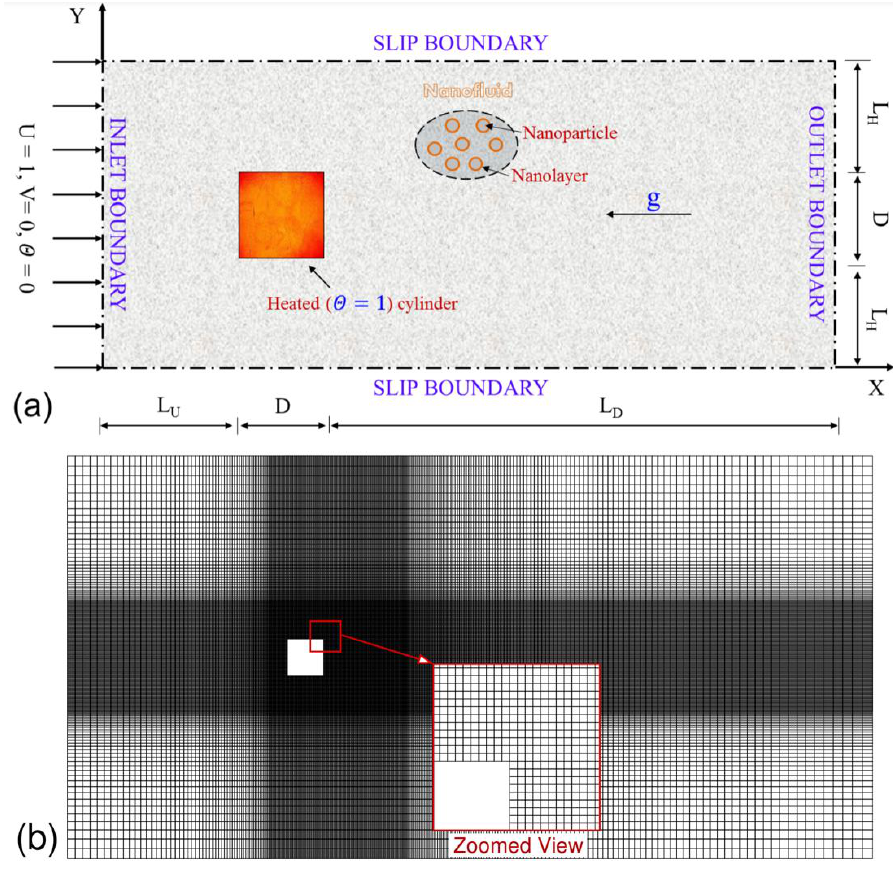
Figure 1. ( a ) Sketch of the computational domain and its coordinate system along with the imposed boundary conditions. ( b ) Non-uniform mesh